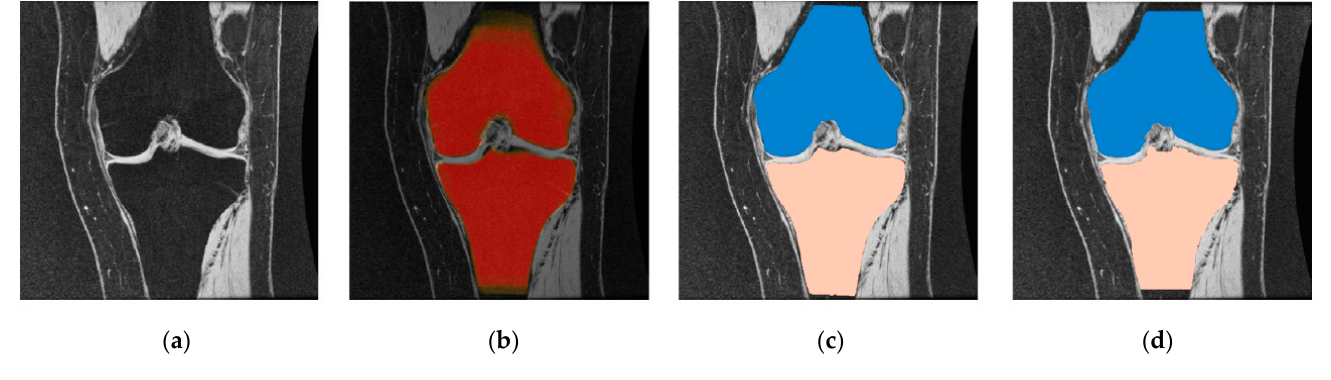
Figure 5. One sample slice’s bone segmentation in coronal view. ( a ) Original image; ( b ) multi-atlas-based spatial prior; ( c ) segmentation result; ( d ) expert segmentation [49].